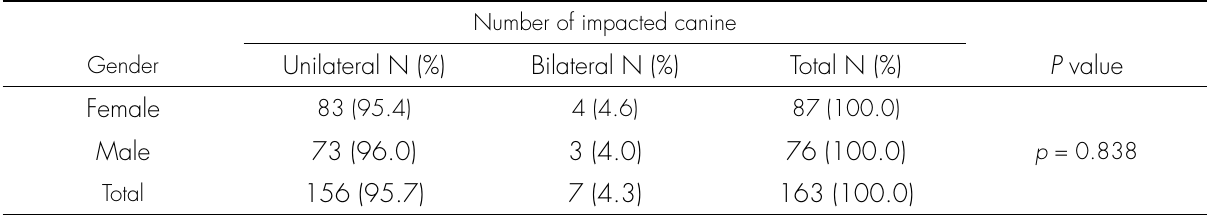
* Indicates statistical significance ( p ≤ 0.05) Table III. Number of patients with impacted canine according to